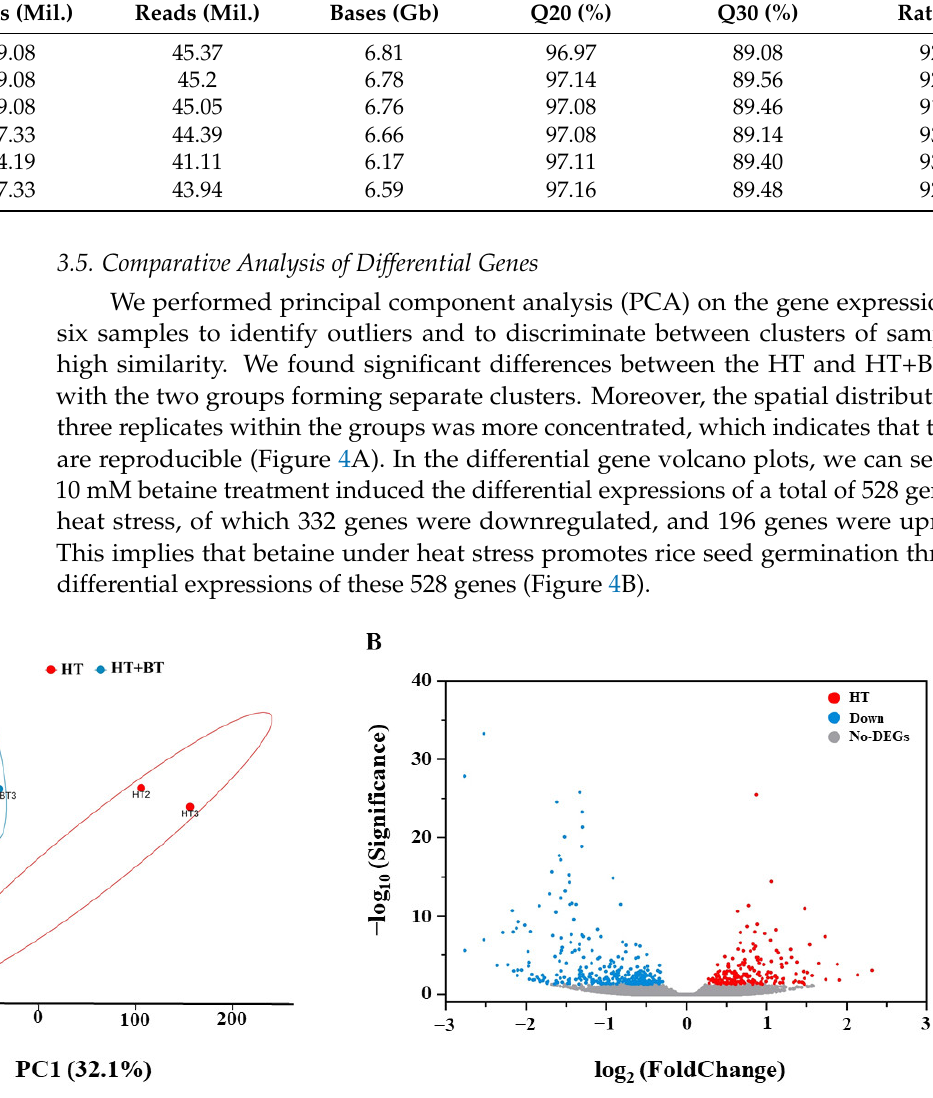
Table 2. Output and quality of sample sequencing data.